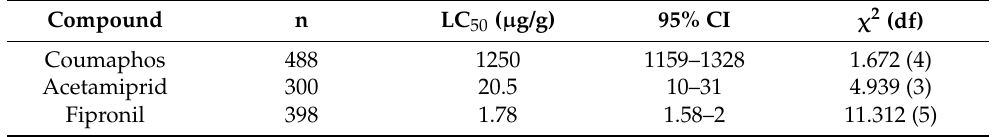
Table 2. Small hive beetle acute toxicity Lethal Concentration 50 (LC 50 ) values with 95% confidence intervals and chi-square values generated in PoloPlus.